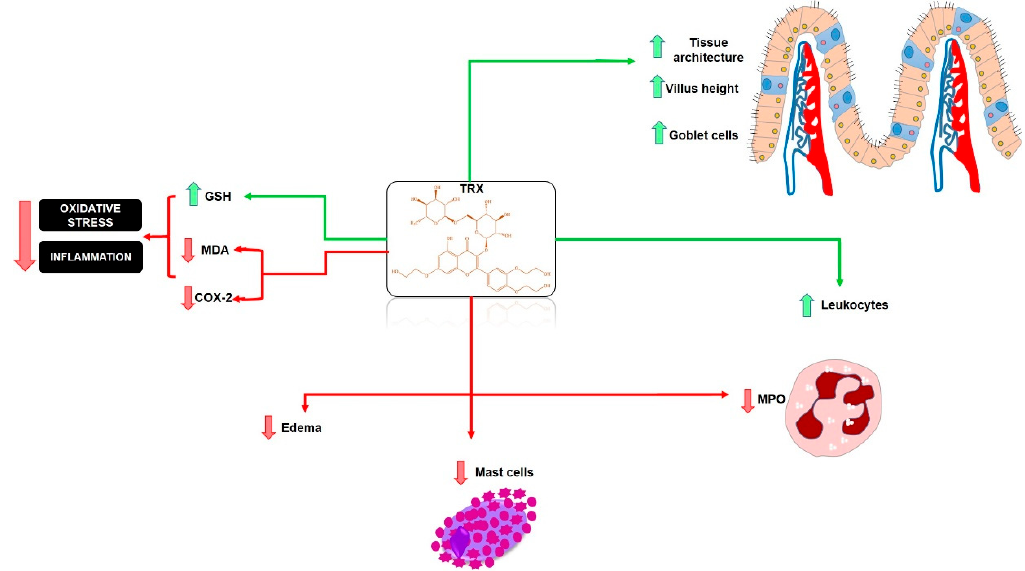
Figure 10. Hypothetical chemopreventive effect of TRX in intestinal mucositis induced by 5-FU. TRX prevented intestinal inflammation by inhibiting MDA, MPO, COX-2, ROS, mastocytosis, and inhibition of leukopenia. TRX also stimulated increased villi and increased levels of the antioxidant GSH. TRX: troxerutin; ROS: reactive oxygen species; COX-2: cyclooxygenase 2; MDA: malondialdehyde; MPO: myeloperoxidase; GSH: reduced glutathione. Green arrows (stimulate / increase), red arrows (inhibit).